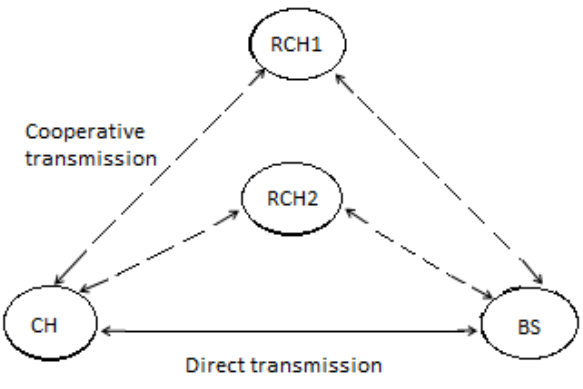
Figure 5. Cooperative